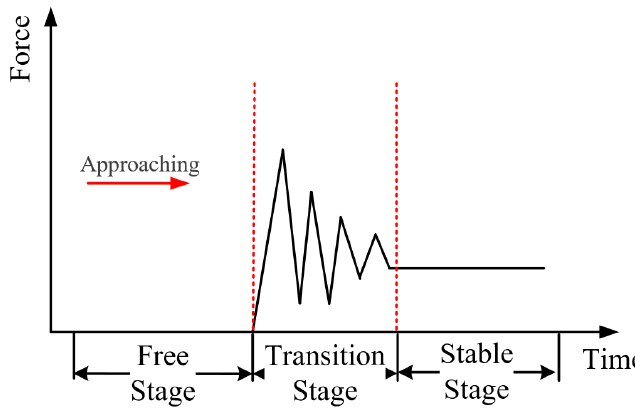
Figure 4. Grinding Stages.